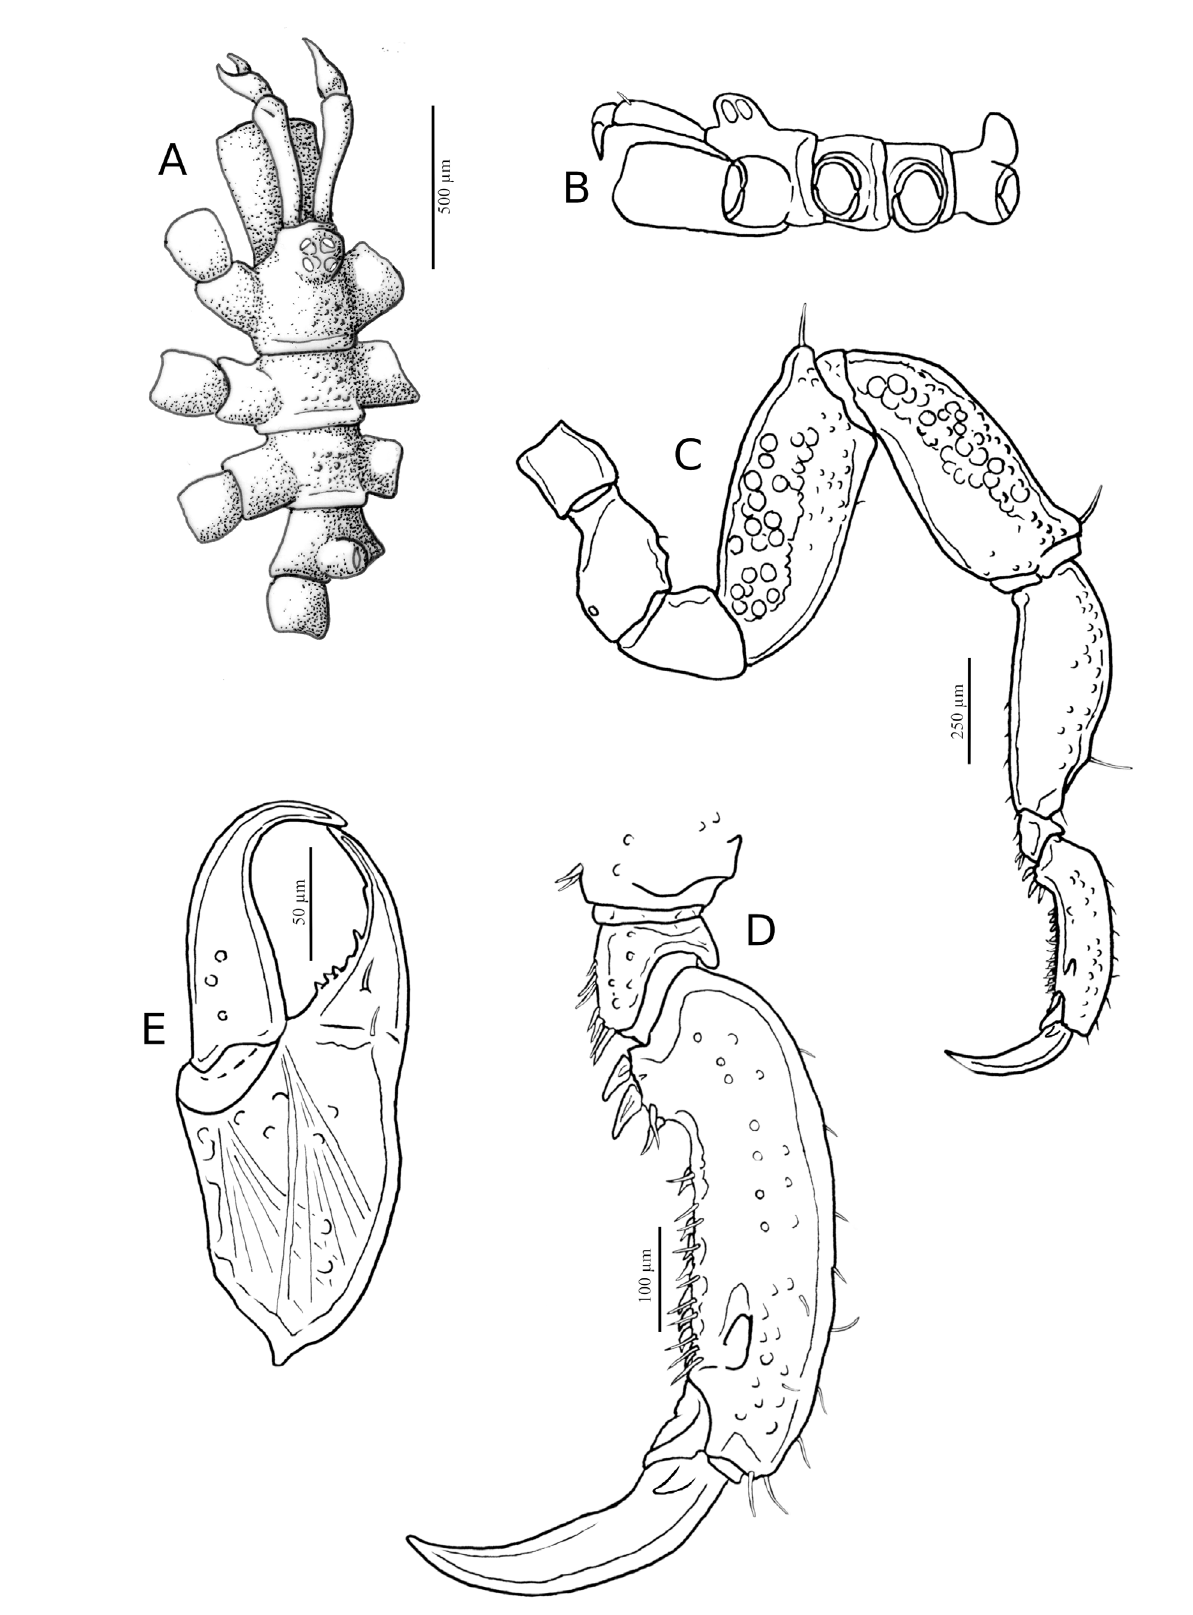
Fig. 27. Anoplodactylus sp. 8, ♀, MNHN-IU-2016-1060. A . Body, dorsal view. B . Body, lateral view (same scale as A). C . Third leg. D . Tarsus and propodus of third leg. E .